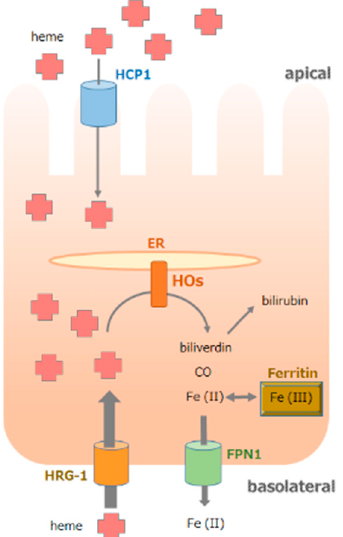
Figure 1. Heme utilization system as an iron-supplying system in gastrointestinal cells. In intestinal epithelial cells, heme is transported by heme carrier protein 1 (HCP1) from the apical membrane and by heme responsive gene-1 (HRG-1) from the basolateral membrane. The heme is more readily absorbed from the basolateral side than from the apical side. Since the catalytic sites of ER membrane-bound heme oxygenases (HOs) are in the cytosol, heme is degraded to biliverdin, which is rapidly reduced to bilirubin by biliverdin reductase in the cytosol. Fe (II) produced by the HO reaction is incorporated into ferritin or exported into tissue fluids via ferroportin 1